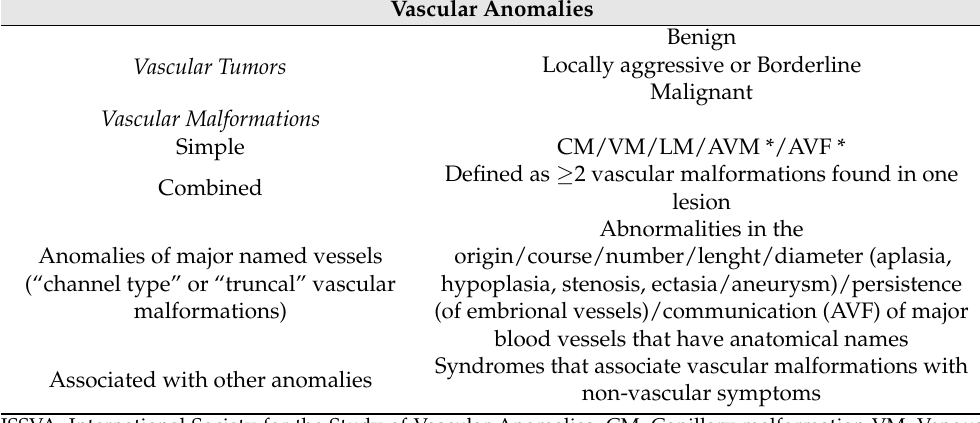
Table 1. Classification of Vascular Anomalies According to ISSVA (2018) [2]. Vascular Anomalies Benign Locally aggressive or Borderline Vascular Tumors Malignant Vascular Malformations Simple CM/VM/LM/AVM */AVF * Defined as ≥ 2 vascular malformations found in one Combined lesion Abnormalities in the Anomalies of major named vessels origin/course/number/lenght/diameter (aplasia, (“channel type” or “truncal” vascular hypoplasia, stenosis, ectasia/aneurysm)/persistence (of embrional vessels)/communication (AVF) of major malformations) blood vessels that have anatomical names Syndromes that associate vascular malformations with Associated with other anomalies non-vascular